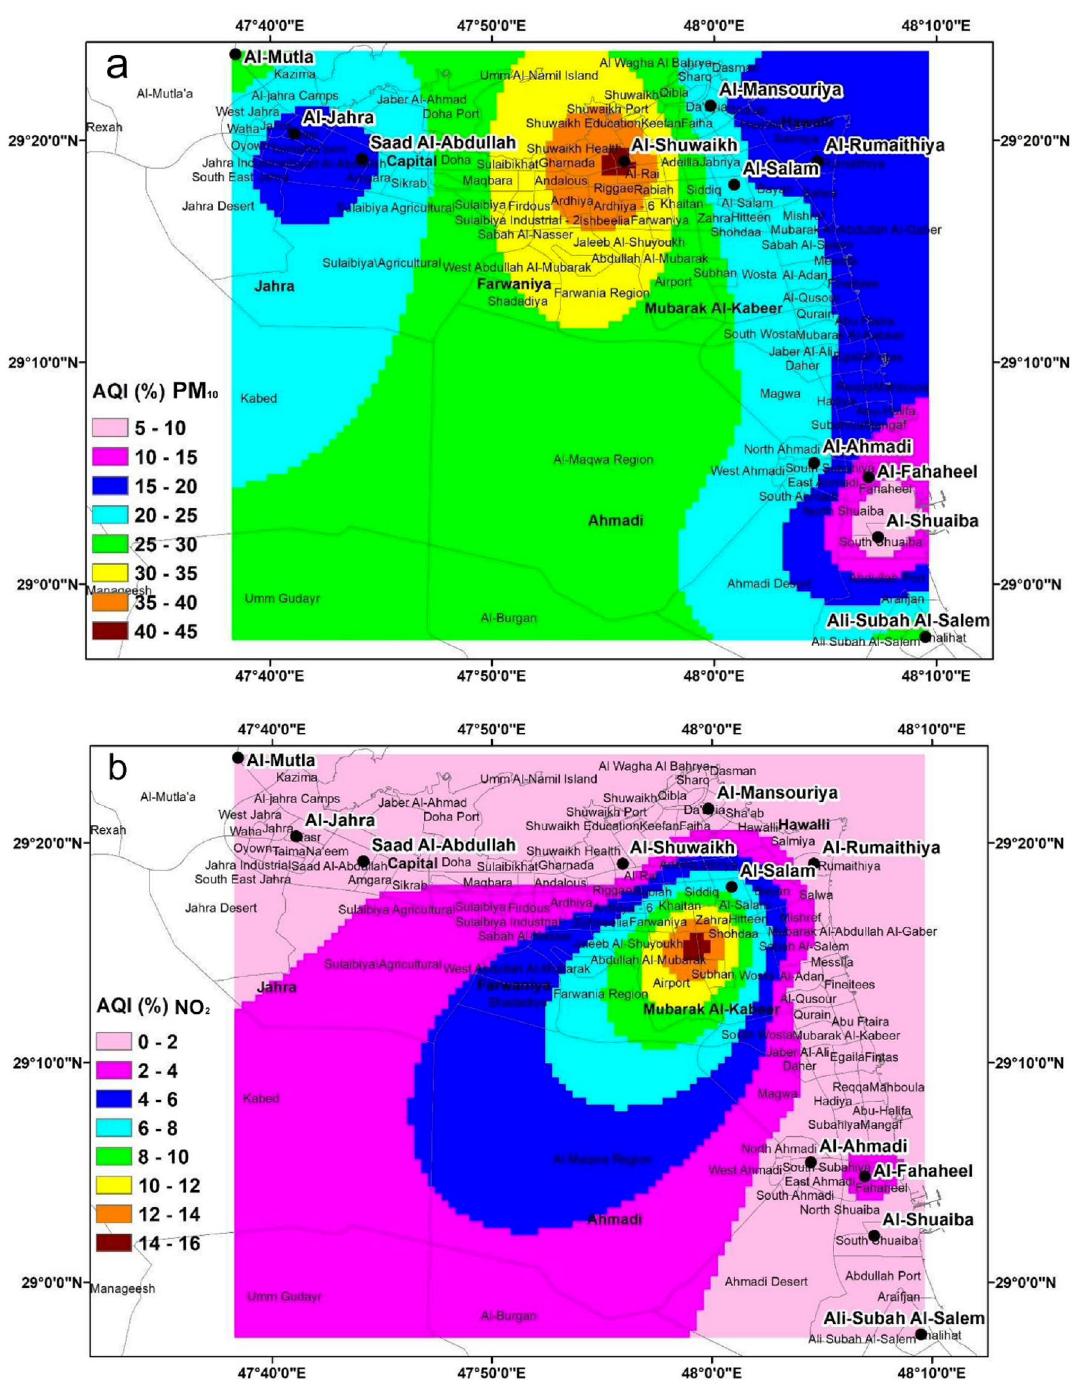
Fig. 10 Air pollution hazard maps for Kuwait based on 2014–2017 data: a PM Research